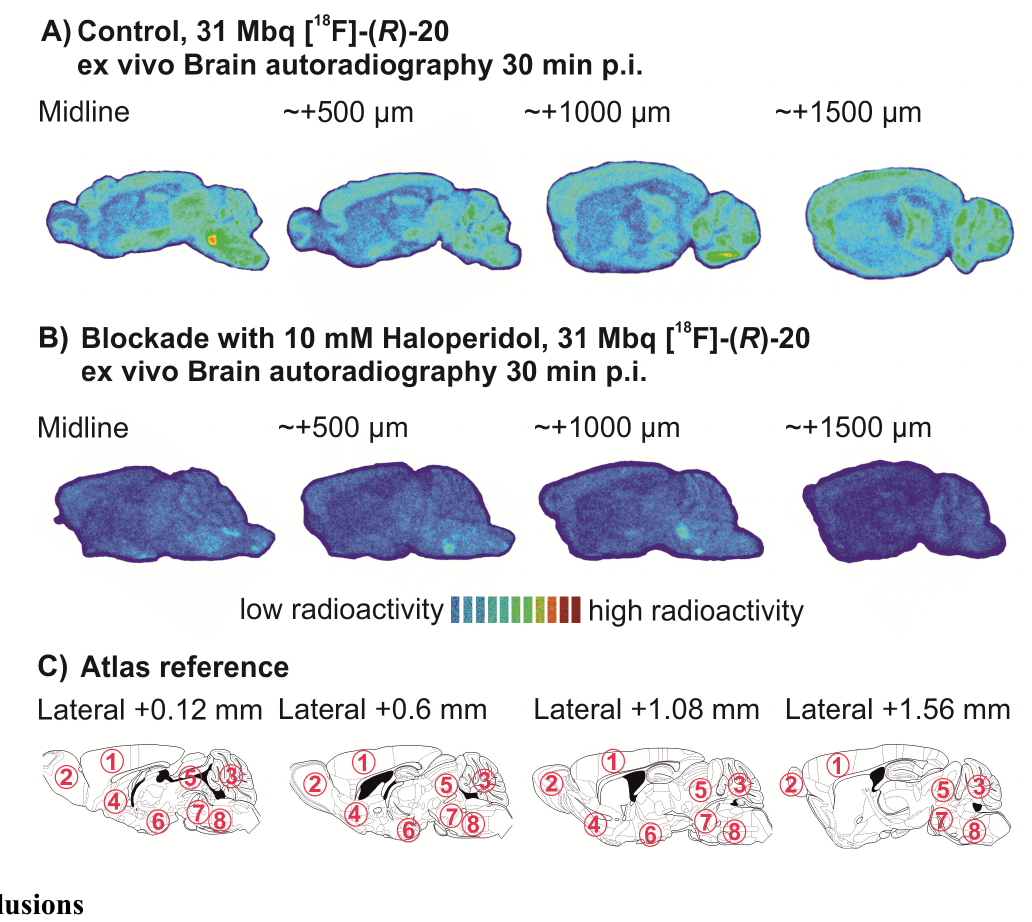
Figure 5. Ex vivo brain autoradiographs under control ( A ) and blockade ( B ) conditions. Anatomical reference (Mouse Atlas, Paxinos & Franklin) is shown in C. Numbers indicate the following major brain regions: 1, Cerebral cortex; 2, Olfactory bulb; 3, Cerebellum; 4, Basal forebrain; 5, Midbrain; 6, Hypothalamus; 7, Pons; 8,